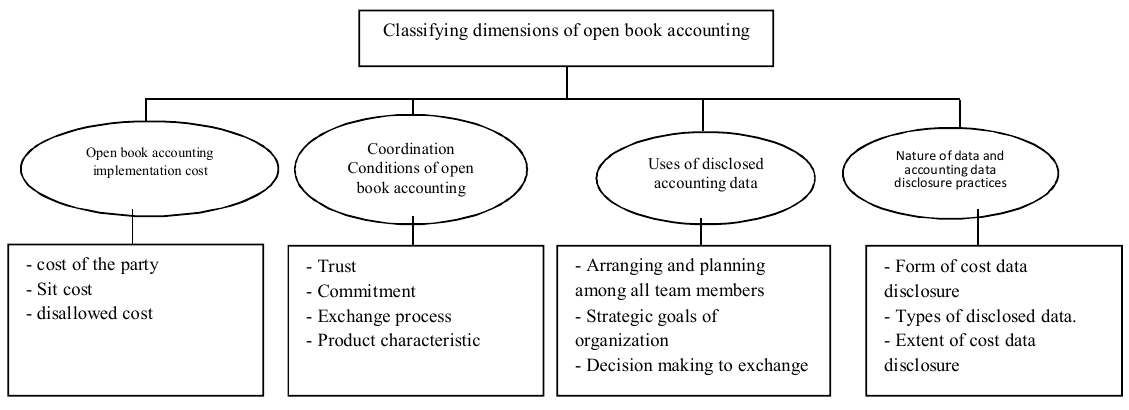
Fig. 1. The conceptual